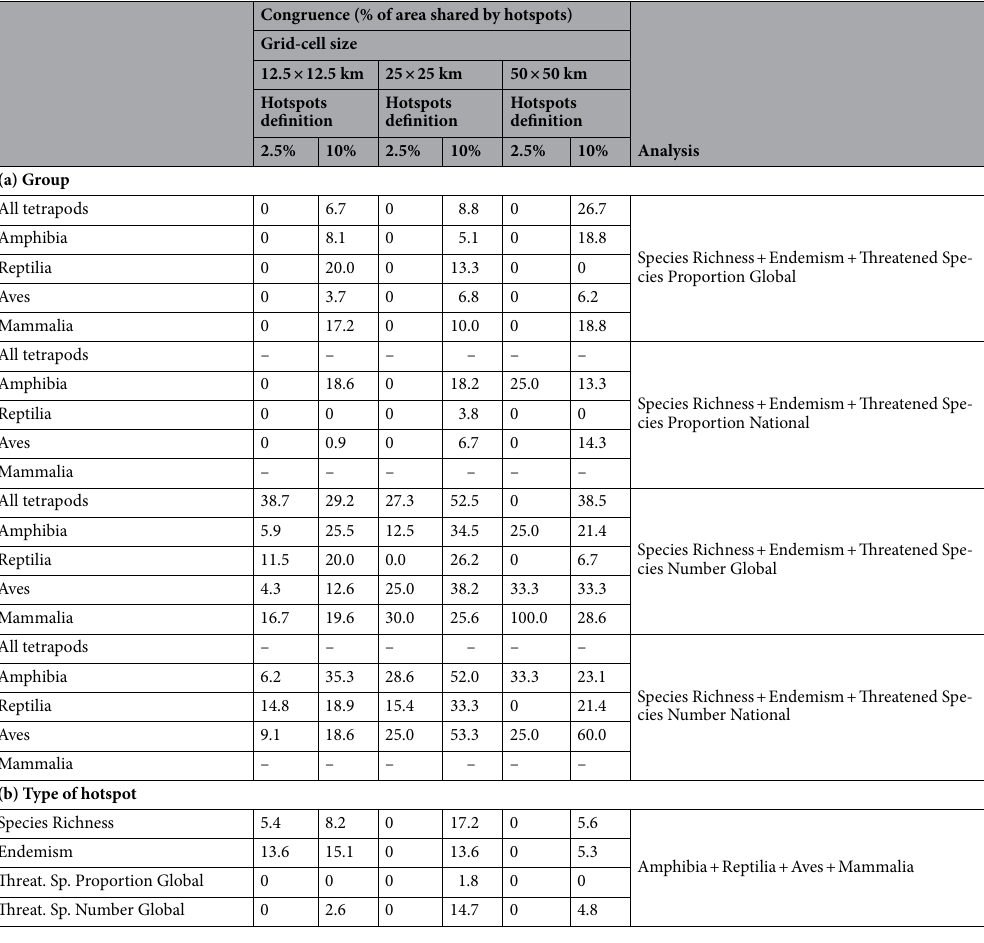
Table 2. Hotspots congruence. The extent of spatial congruence of (a) all types of hotspots considering all tetrapods and each tetrapod group and (b) each different type of hotspots considering all tetrapods together; varying both the size of the sampling unit (12.5x, 25 × and 50 × km) and the criterion to define a hotspots (%2.5 or 10% of area/number of cells occupied by